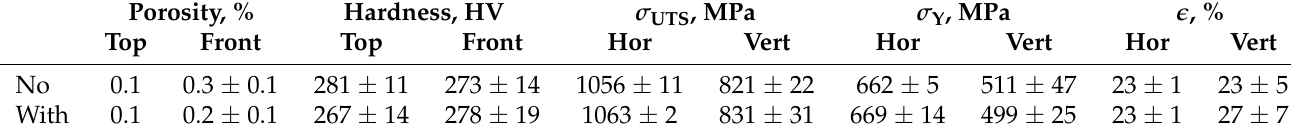
Table 5. Measured planar porosity, Vickers microhardness, and tensile strength values for fabricated Inconel 718 horizontal and vertical specimens under no and superimposed MF conditions.